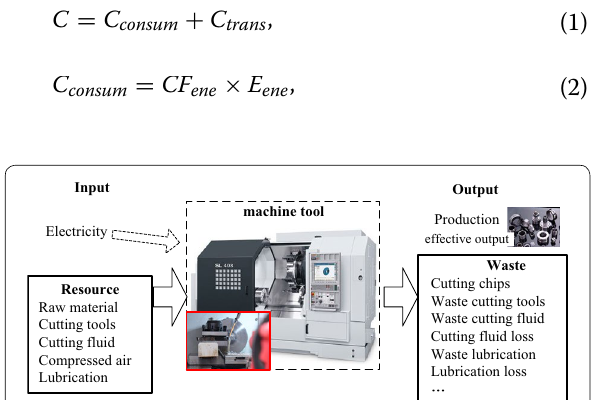
Figure 2 Input–output analysis of machine